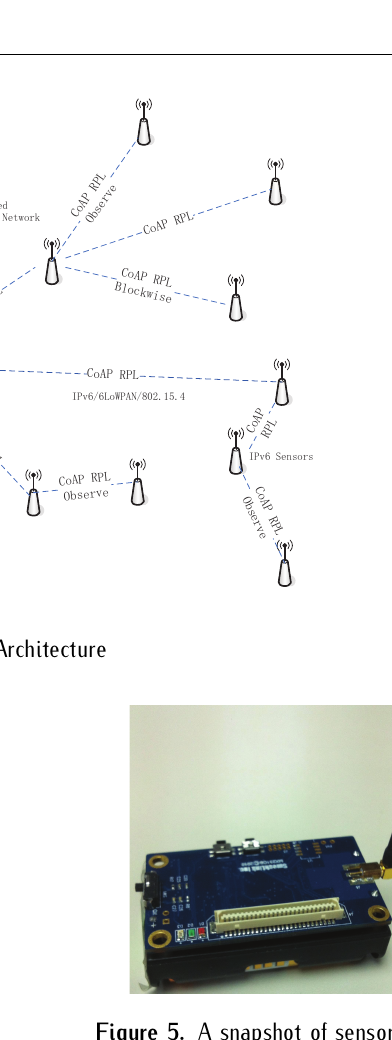
Figure 5. A snapshot of sensor